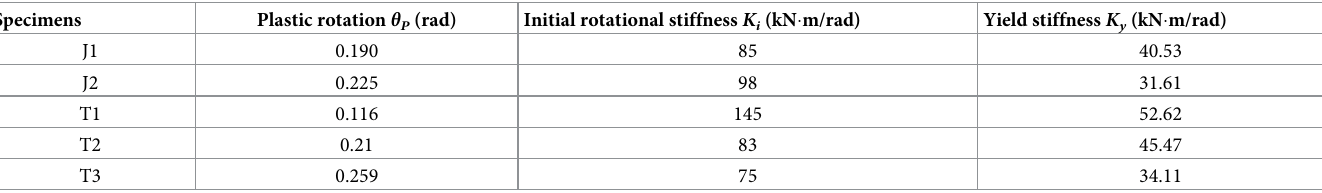
Table 3. Plastic rotation, initial rotational stiffness and yield stiffness for specimens.